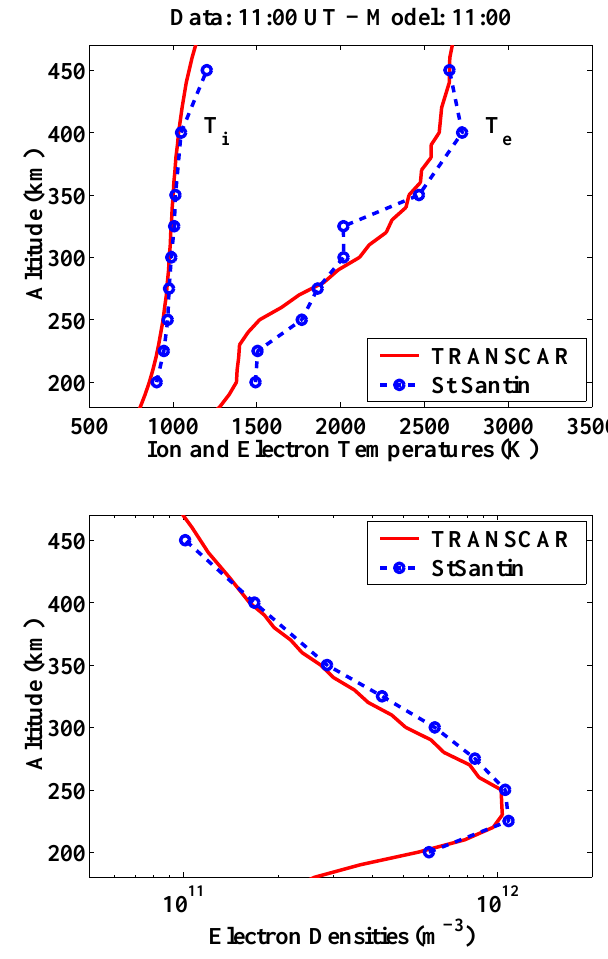
Fig. 1. Altitude profile of electron densities (bottom panel), elec- tron and ion temperatures (top panel) observed by the St. Santin Incoherent Scatter on 27 January 1972 (symbols and broken lines), and TRANSCAR simulation